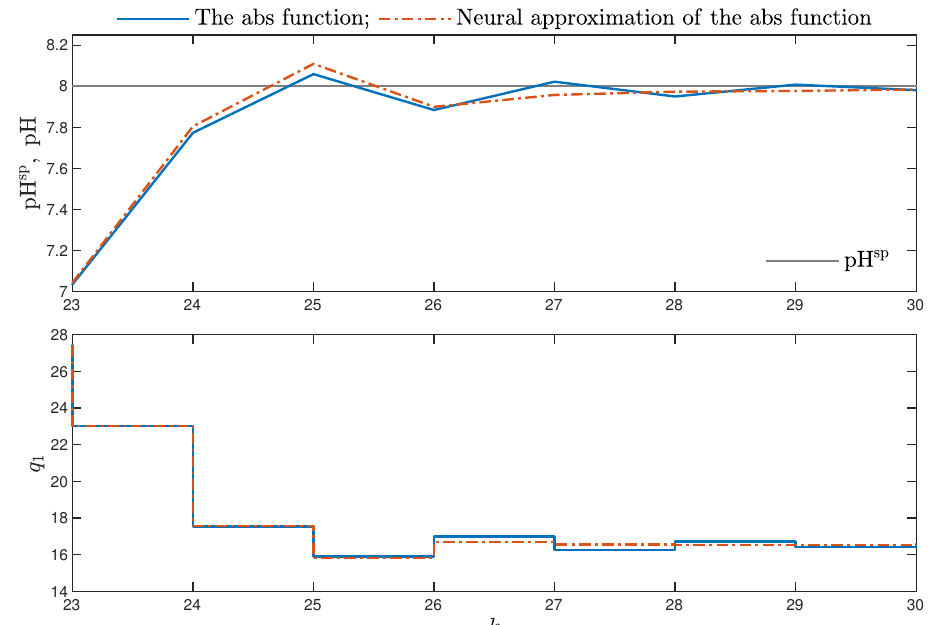
Figure 2. Simulation results: the MPC-NO-L 1 algorithm using the non-differentiable absolute value function vs. the MPC-NO-L 1 algorithm using the neural approximation of the absolute value function; two top panels show the results for the whole simulation horizon, two bottom panels show an enlarged fragment for the sampling instants 23 ≤ k ≤